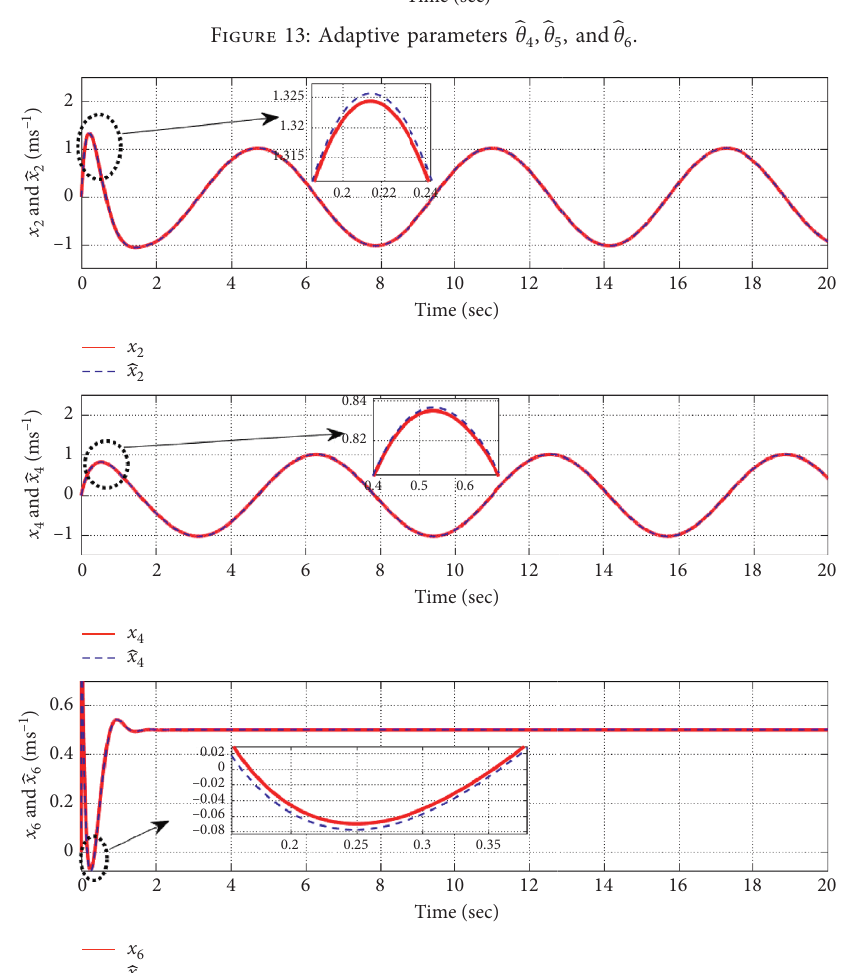
Figure 13: Adaptive parameters 􏽢 θ